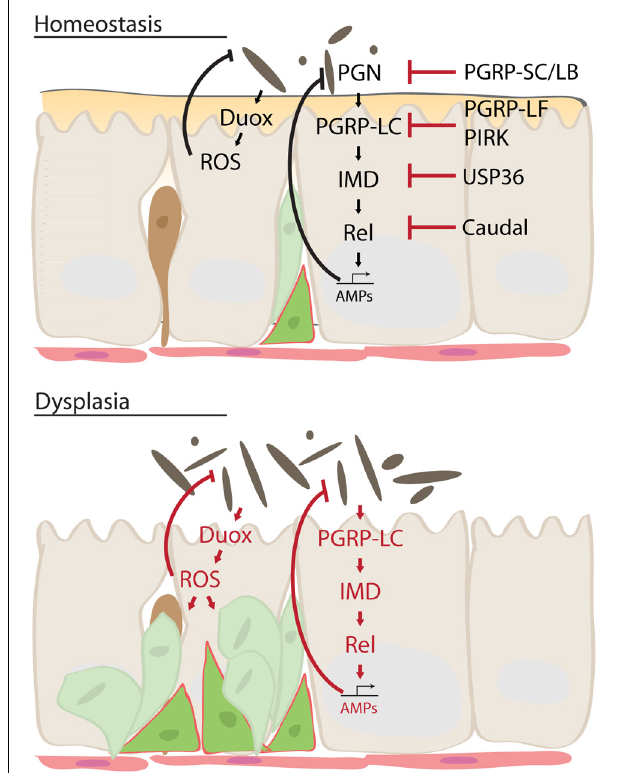
FIGURE 2 | Mechanism of intestinal dysplasia. Under normal homeostatic conditions, activity of Immune deficiency (IMD) pathway is tightly regulated by multiple factors. This ensures moderate innate immune response sufficient to keep intestinal microbes in check while preventing excessive immune activation. In an aging intestine, however, loss of these regulatory mechanisms leads to chronic inflammation and dysbiosis, which results in dysplasia and disruption of tissue homeostasis. Dual oxidase (Duox), reactive oxygen species (ROS), peptidoglycan (PGRP), Relish (Rel), poor Imd response upon knock-in (PIRK), antimicrobial peptides